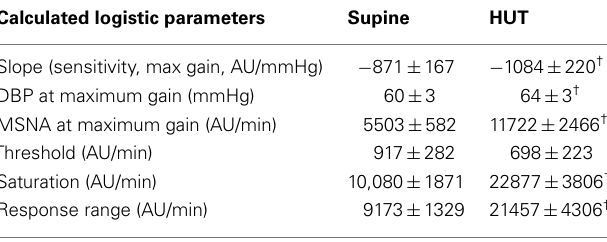
Table 5 | Calculated total MSNA baroreflex sensitivity (slopes), threshold, saturation, and response range using the modified Oxford